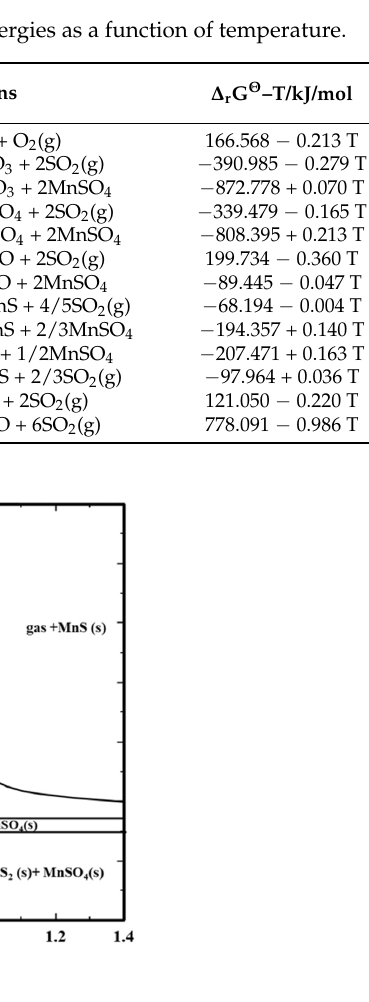
Figure 5. Predominant phase diagram as functions of temperature and input S 2 (g) fraction in the S 2 – MnO 2